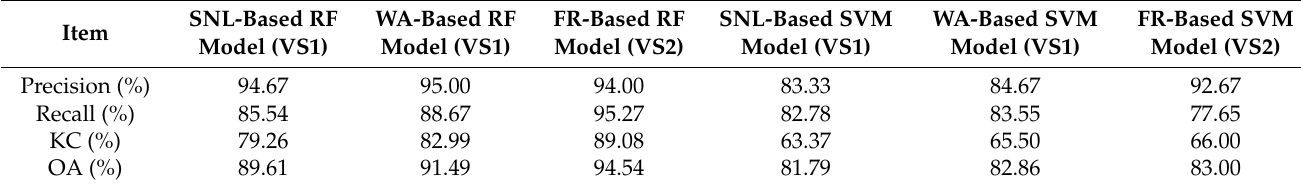
Table 2. Performance of the RF and SVM algorithms vs. validation sets (VS1 and VS2).